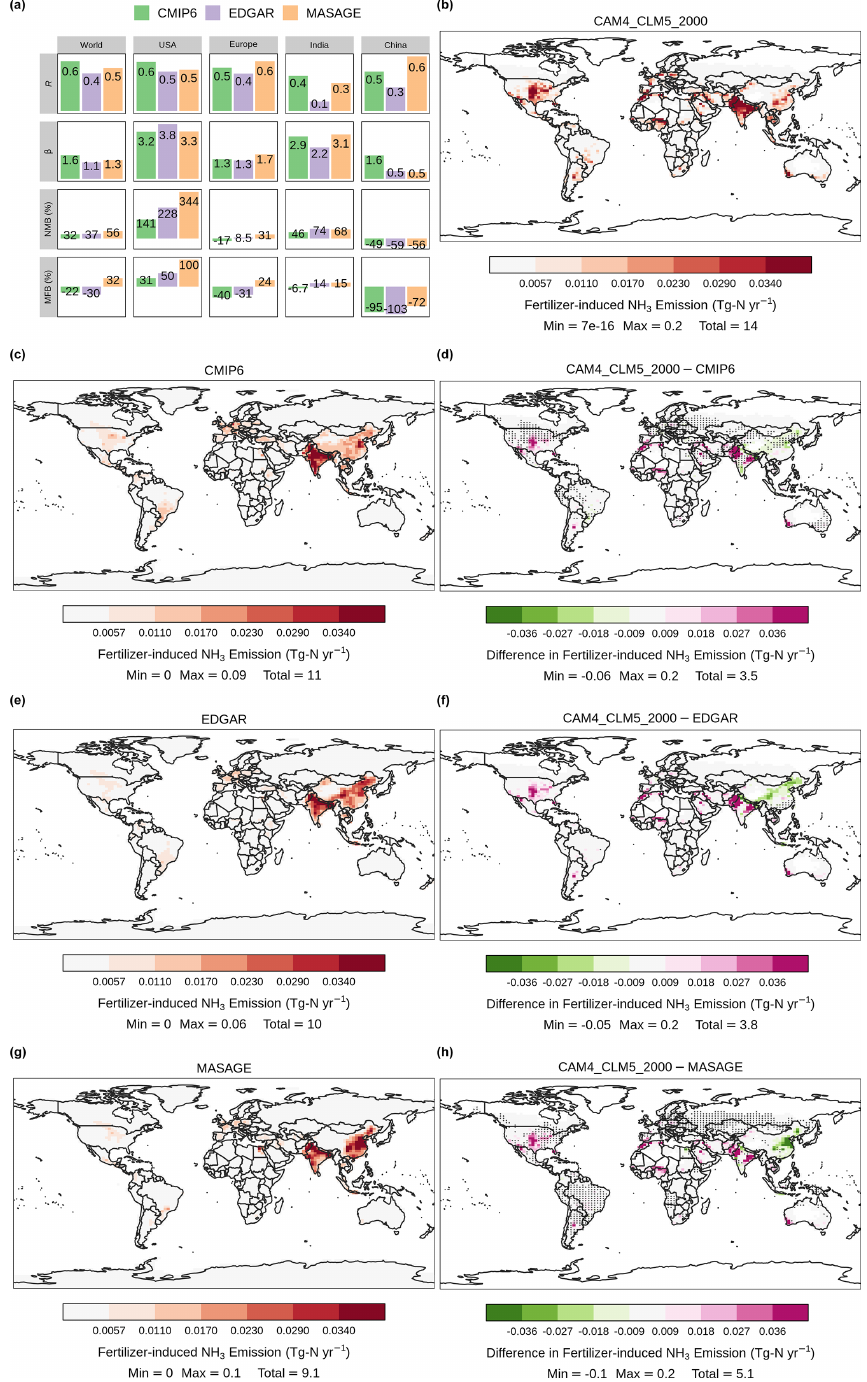
Figure 2. Fertilizer-induced NH 3 emission estimated by CLM5 (synthetic and manure) and other emission inventories (synthetic only). Correlation analysis between CLM5-simulated annual-total emission and other inventories with regional breakdowns is summarized in (a) . Spatial distribution of annual-total fertilizer-induced NH 3 emission simulated by [CAM4_CLM5_2000] and estimated by CMIP6, EDGAR, and MASAGE is illustrated in (b) , (c) , (e) , and (g) , respectively. Panels (d) , (f) , and (h) show the spatial distribution of differences in annual- total NH 3 between CLM5 and CMIP6, EDGAR, and MASAGE, correspondingly. Overlaying black dots in the difference maps indicate grid cells with a high statistically significant spatiotemporal correlation (i.e., R 2 > 50%, p < 0 . 05) between CLM5 and the corresponding inventories. Color scales are saturated at respective values, and ranges of values are shown in the legend